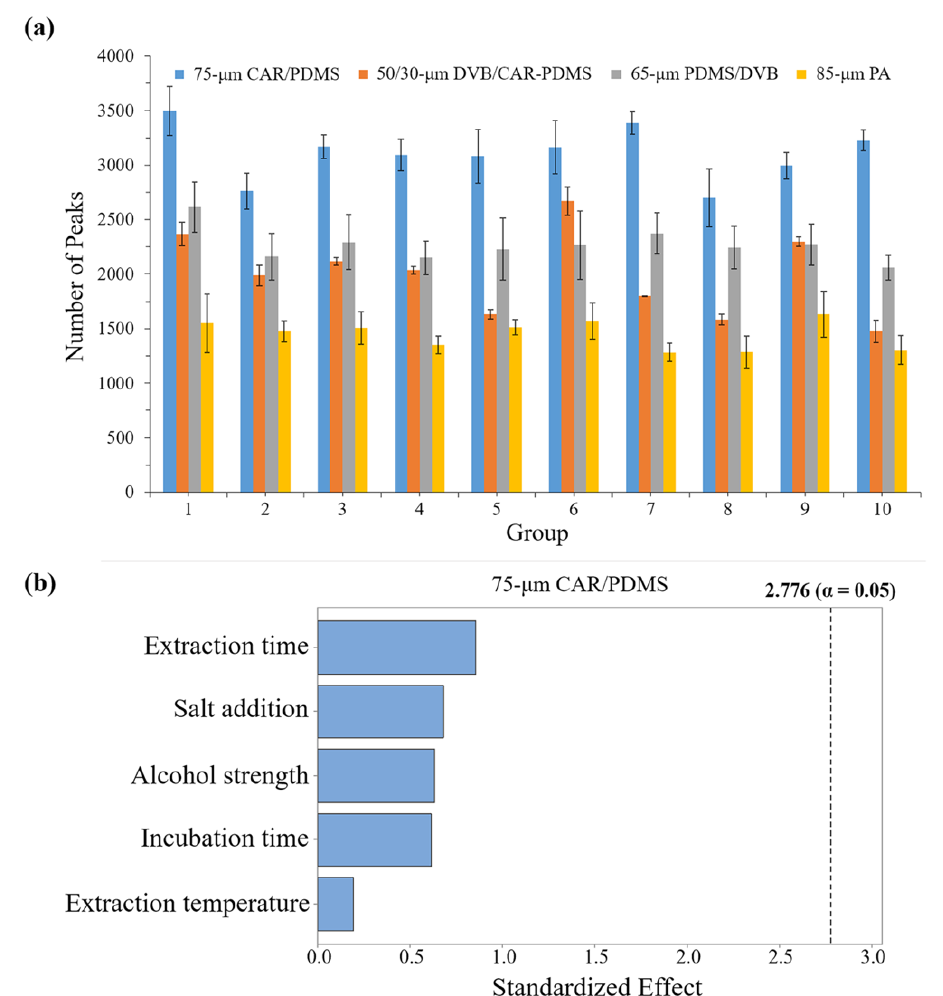
Figure 3. Results of the number of peaks of the different fibers and the Pareto chart of the 75- µ m CAR/PDMS. Comparison of the extraction efficiency for each fiber by testing the different groups used in the experiment and measured as number of peaks ( a ). Standardized main effect Pareto chart, representing the estimated effects of the parameters obtained from the P-B design for the determination of the 75- µ m CAR/PDMS, Vertical line in the chart defines 95% confidence level ( b ).